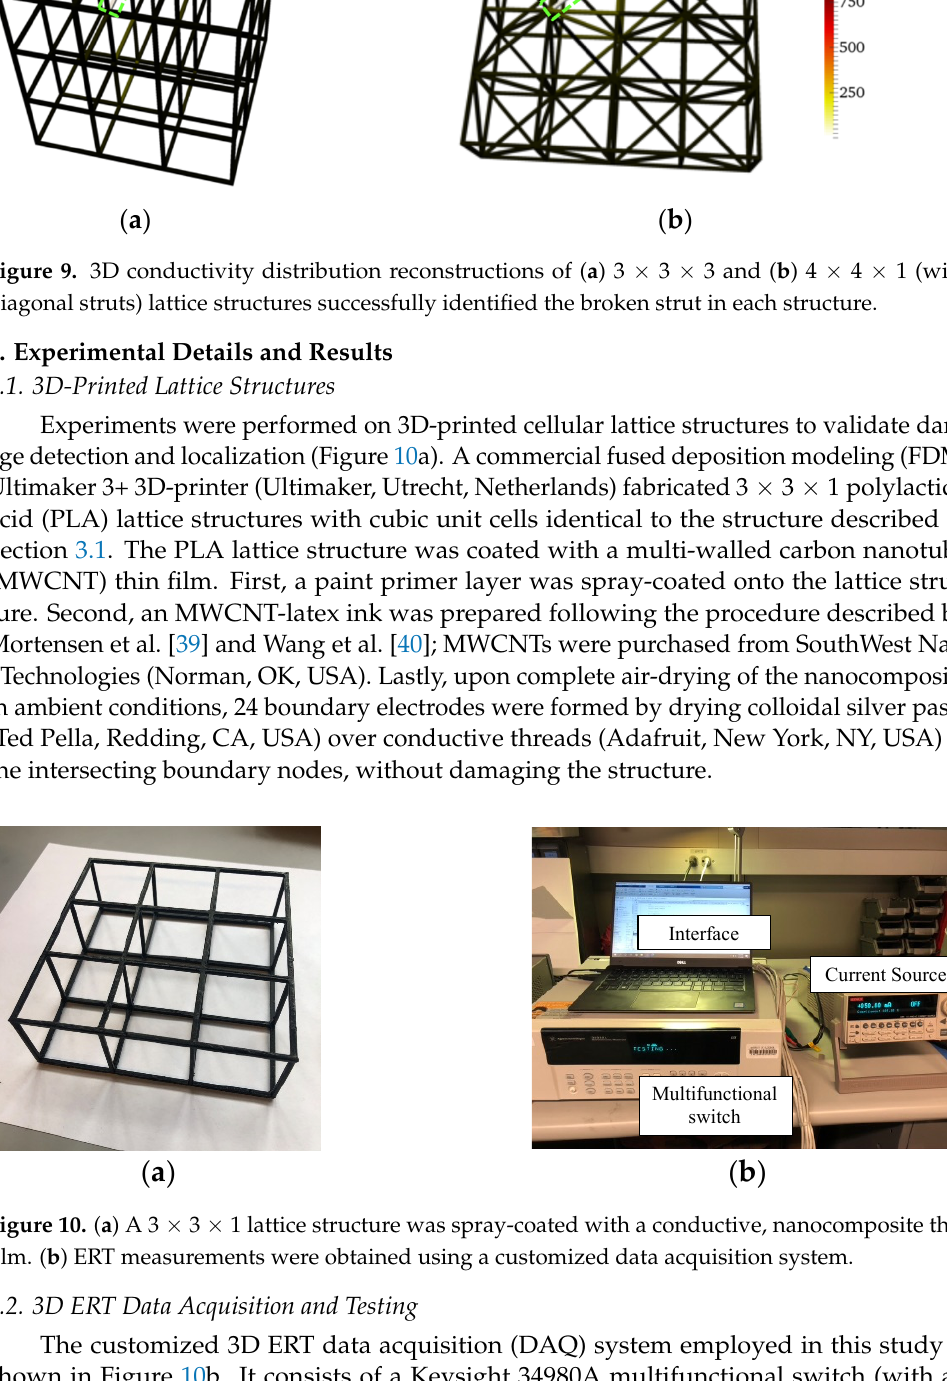
( d ) Figure 8. ( a ) A lattice structure with two damaged struts. ( b ) The reconstructed conductivity values of each element when solved without the normalized sensitivity map. ( c ) The reconstructed 3D con- ductivity distribution and ( d ) the conductivity values for each element, when solved using the nor- malized sensitivity map. 3.6. Defect Detection in Complex Lattice Structures The effectiveness of this method was validated by considering full strut breakages in other complex lattice structures. Simulations were conducted using a 3 × 3 × 3 lattice with cubic unit cells, as well as a 4 × 4 × 1 lattice structure with diagonal struts. Similar to pre- vious cases, boundary electrodes were defined as the intersecting nodes along the bound- aries. For the 3 × 3 × 3 lattice, only the top and bottom faces (i.e., top and bottom z-planes) had electrodes for a total of 24 boundary electrodes. On the other hand, the 4 × 4 × 1 lattice